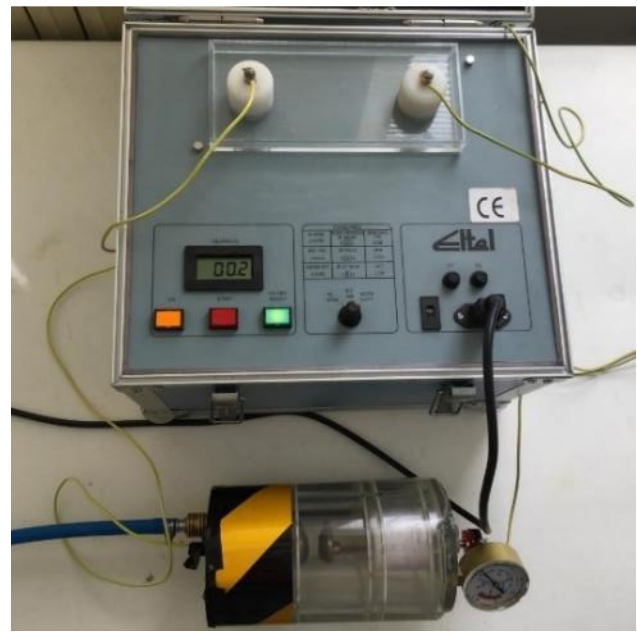
Figure 2. Test cell and breakdown voltage tester.